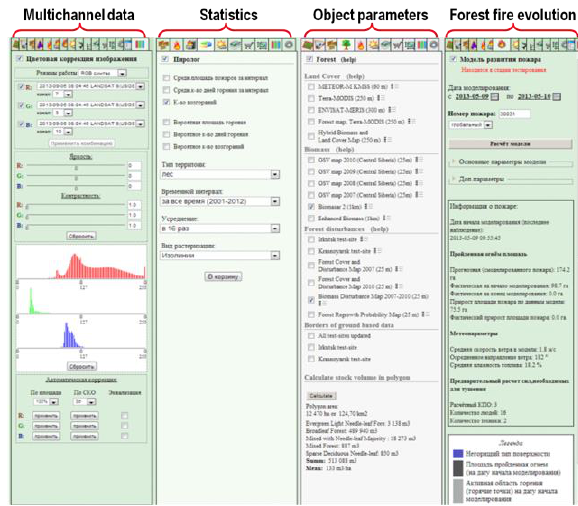
Figure 3. Examples of special information panel for data analysis